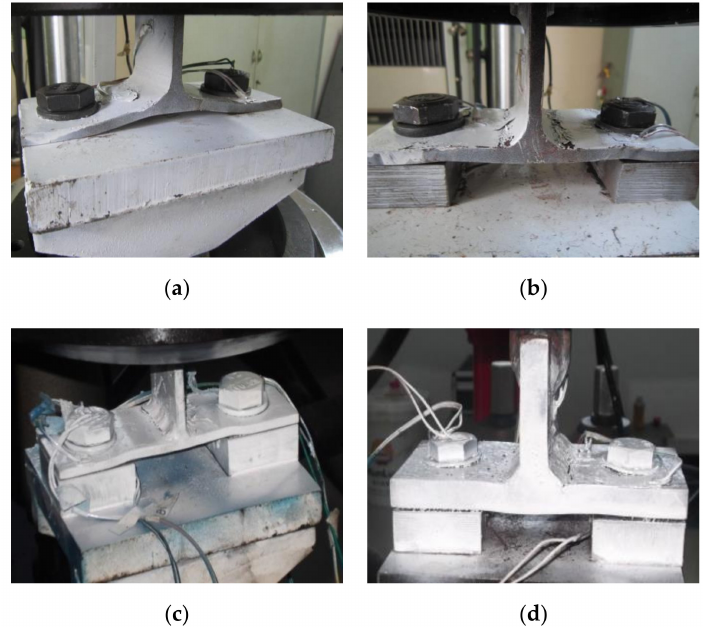
Figure 9. Failure modes of four representative specimens of three di ff erent groups under cyclic